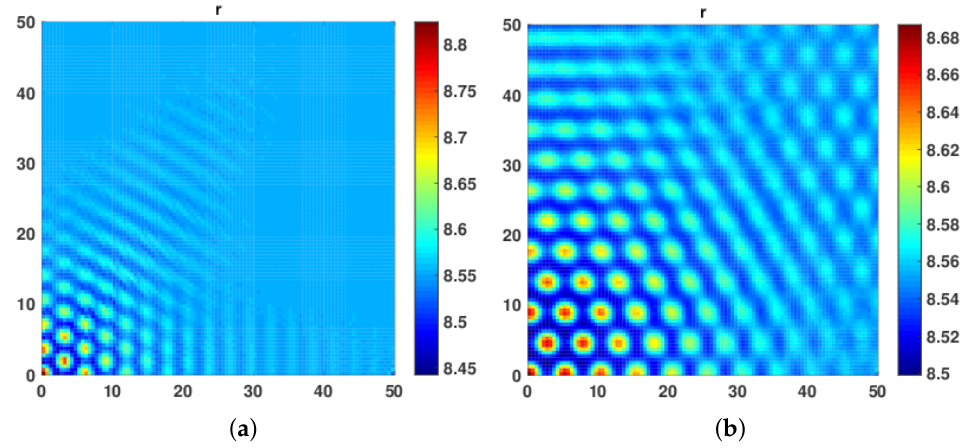
Figure 6. ( a ) A mixture of Hot Spot and Labyrinth Turing patterns obtained at d 3 = d 4 = 0.5. ( b ) A mix of Hot Spot and Labyrinth Turing patterns obtained at d 3 = d 4 = 1.